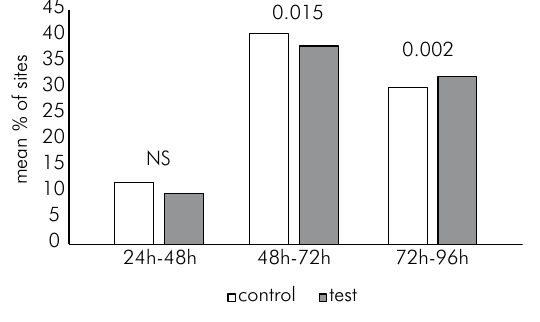
Figure 4. Percentage of conversion from scores 0 and 1 to score 2 (presence of subgingival biofilm) between time periods, for proximal surfaces.